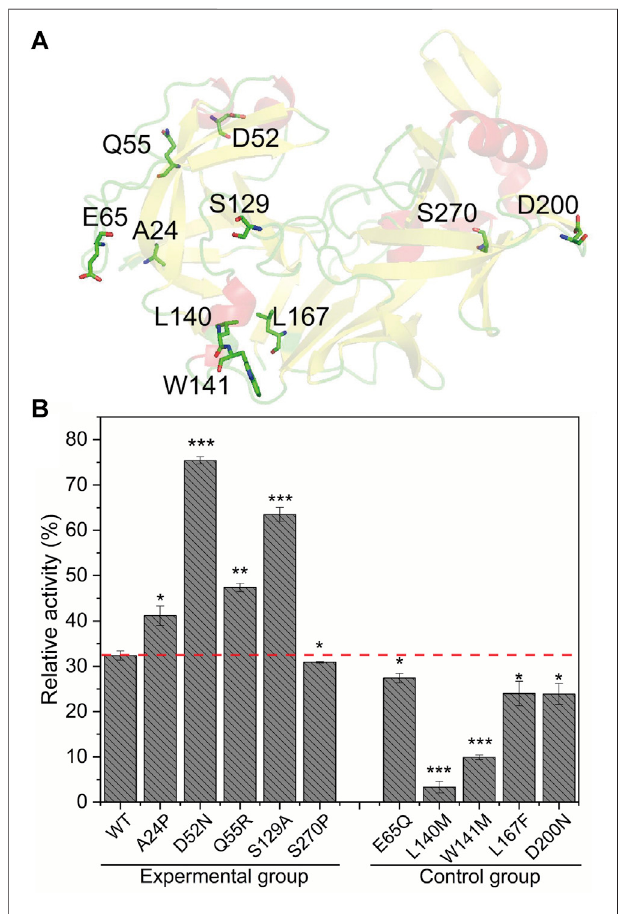
FIGURE 3 | Analysis of the positions and thermostability results of mutations predicted using Fireprot based on evolution. (A) Positions of mutations on the pepsin structure. (B) Relative activities of mutants after incubation at 65 ° C for 3 min. Data are mean ± s.e.m. *** p < 0.001, ** p < 0.01, * p < 0.05. Data are from three independent